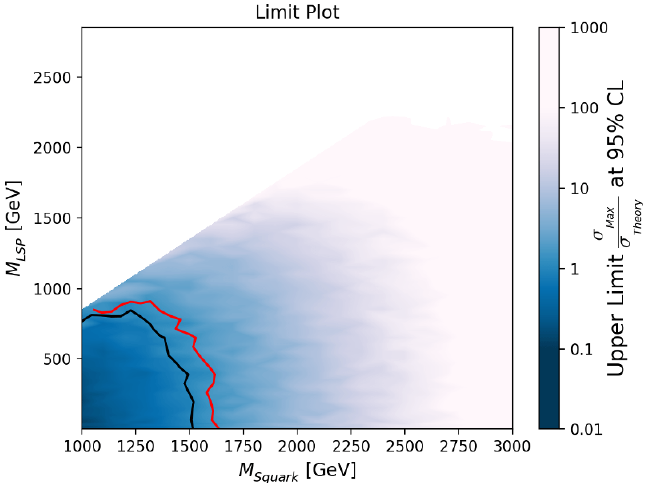
Figure 17. Observed (black) and expected (red) limits for an MSSM-like scenario demonstrating the higher sensitivity to regions with low LSP